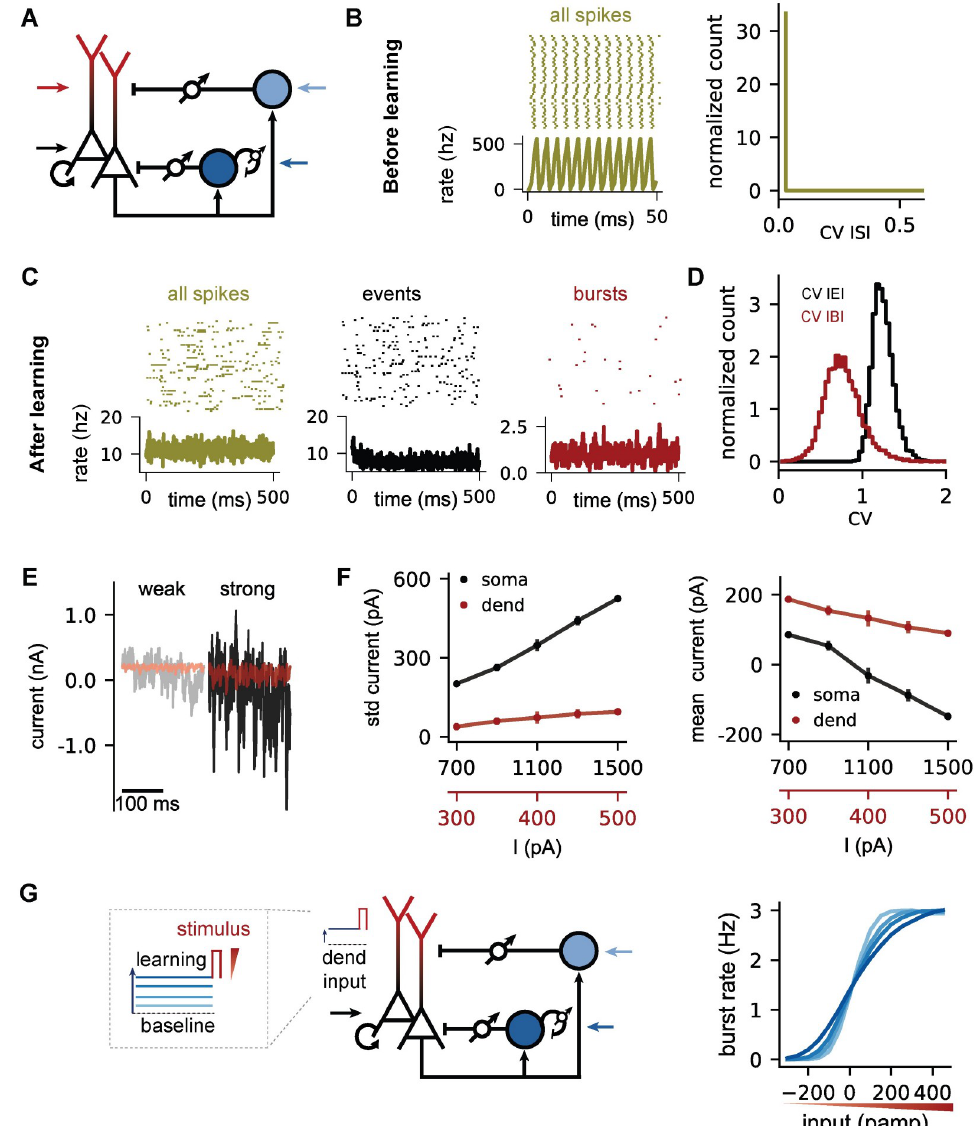
Fig 3. A doubly asynchronous irregular state for both spikes and bursts. (A) Schema of the recurrent circuit structure. All inhibitory connections are plastic (target firing rates = 10 Hz, target burst rate = 1 Hz). For all panels, the external input to soma, dendrites and PVs ( I PV ¼ 200 pA ) is noise-free ( σ s = σ d = σ PV = 0 pA). SOM interneurons do not receive i external input. (B) Left: Spiking pattern of PCs before learning of the inhibitory weights and time-varying population rate. Strong constant somatic ( I s ¼ 1500 pA ) and dendritic ( I d ¼ 500 pA ) external input causes PCs to fire i i synchronously at high rates. No clearly separated bursts are detectable. Right: Regular firing indicated by the distribution of the coefficient of variation (CV) of the inter-spike interval. (C) Raster plots and population rates after learning the inhibitory weights. Events (black) and bursts (red) are isolated from all spikes (dark yellow) to illustrate activity associated with somatic (events) and dendritic (bursts) inputs (see Methods). (D) The firing and burst pattern is irregular as indicated by the distribution of the coefficient of variation (CV) of the inter-burst (red) and inter-event (black) ¼ 700 pA , intervals. (E) Net (exc + inh) input current to the soma (black traces) and dendrites (red traces). Weak ( I s i ¼ 300 pA ) and strong ( I s ¼ 1500 pA , I d ¼ 500 pA ) external input leads to small and large input fluctuations on the I d i i i net input current, respectively. (F) Standard deviation (left) and mean (right) net input currents for soma (black) and dendrites (red) when increasing the external somatic (black X-axis) and dendritic (red X-axis) inputs simultaneously. (G) Left: Microcircuit and stimulation paradigm. During the learning phase, the inhibitory weights change until the somatic (10 Hz) and dendritic target (1.5 Hz) is reached for constant dendritic inputs ranging from weak to strong (blue = 250-350-450-650 pA). Right: Burst rate in response to a transient input stimulus (red) after learning, as a function of I d i the strength of the stimulus (red triangle). Somatic input (black arrow, I s ¼ 1000 pA ) is the same for all dendritic input i conditions.